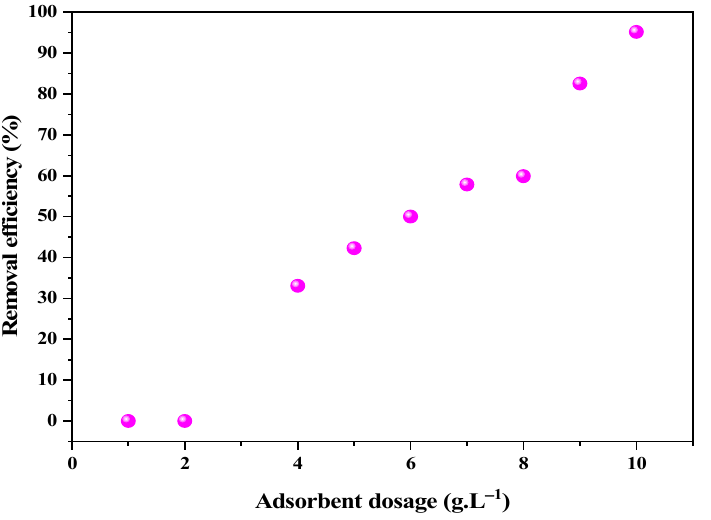
Figure 5. Relationship between MR removal efficiency and adsorbent amount, tested under a treatment of 10 mg.L − 1 MR with 10 g.L − 1 CaSF at 20 °C, stirring the system at 100 rpm for 30